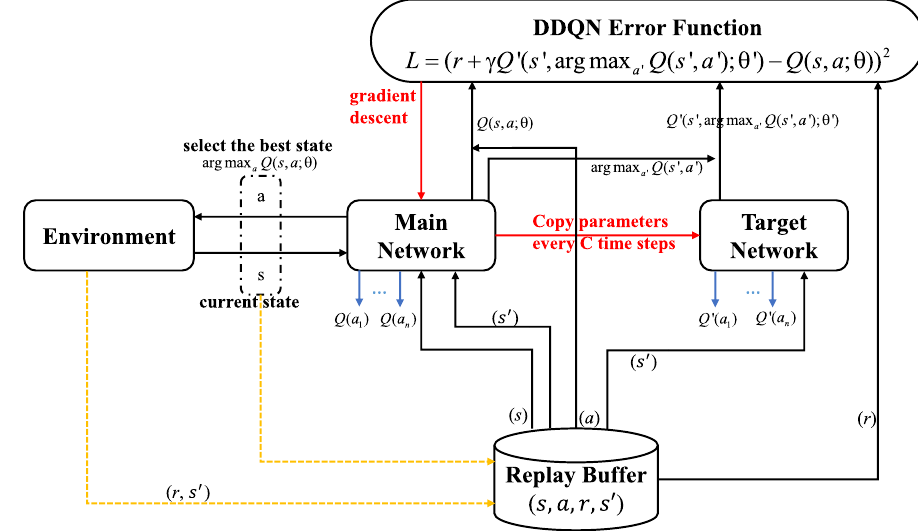
Fig. 4 Algorithm structure diagram of